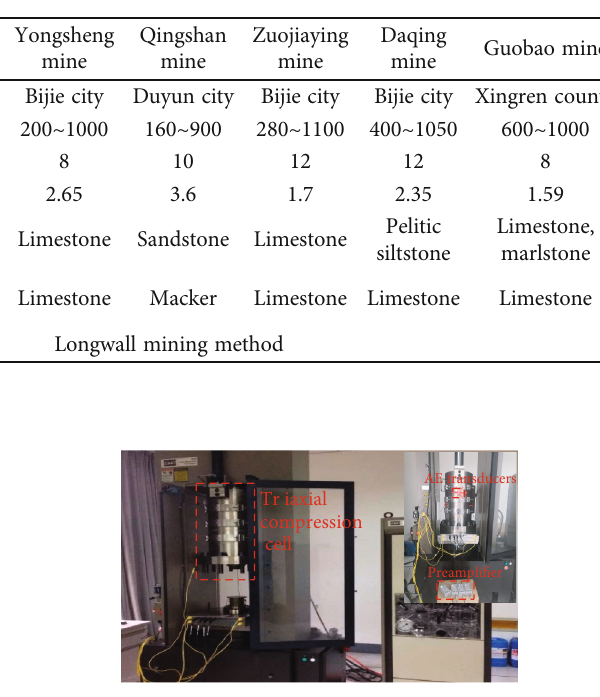
Table 1: Mining forms and slope structure conditions of some mines in mountainous areas of Guizhou.